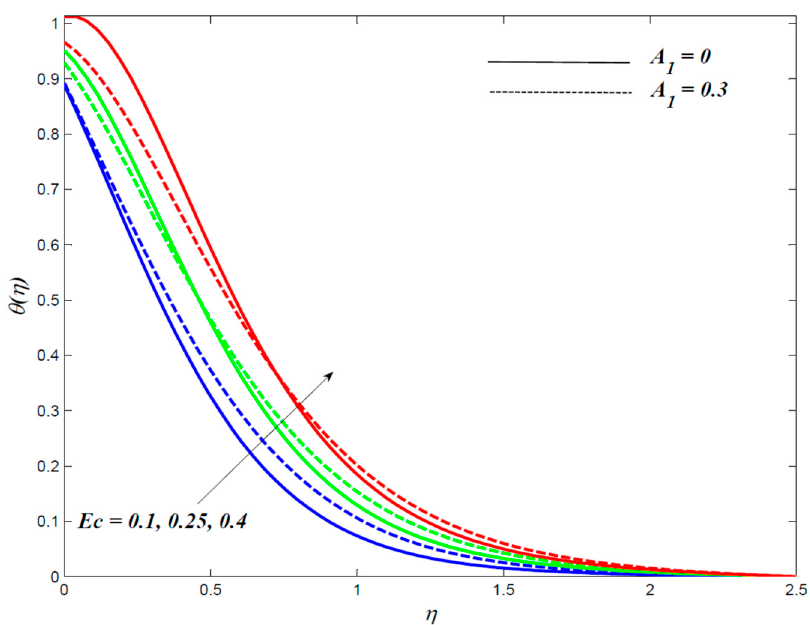
Figure 9. Temperature profiles owing to varying values of Ec .